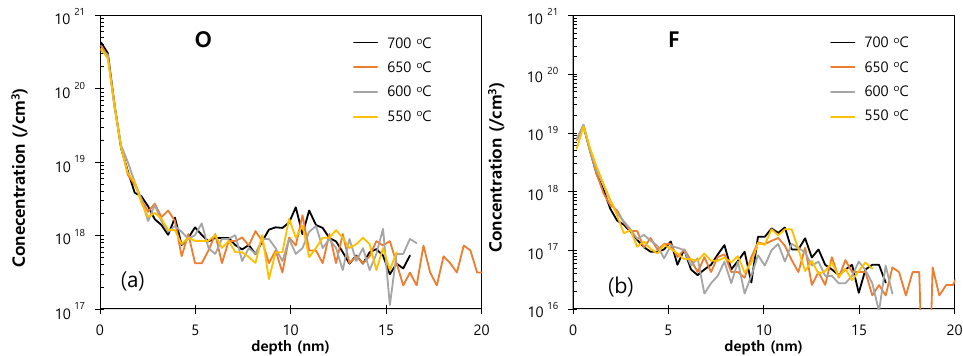
Figure 11. The SIMS O ( a ) and F ( b ) profiles of the Si epitaxial films obtained under various loading temperatures using samples that were dry pre-cleaned.